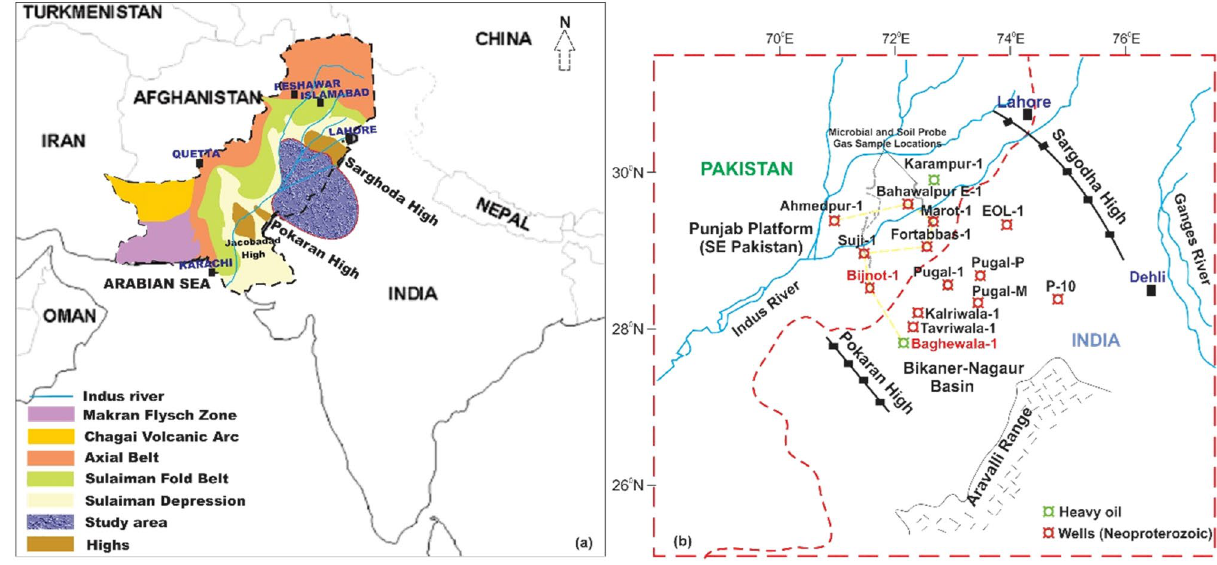
Figure 1. ( a ) Tectonic map of Pakistan indicating structural features and locations of the study area, and ( b ) a map showing wells located in SE Pakistan and Bikaner–Nagaur Basin India 2,32 . The samples were collected from the wells labeled in red font. A yellow line indicates a stratigraphic cross-section in Fig. 3. CorelDRAW X5 was used to create the illustration (www. corel draw.